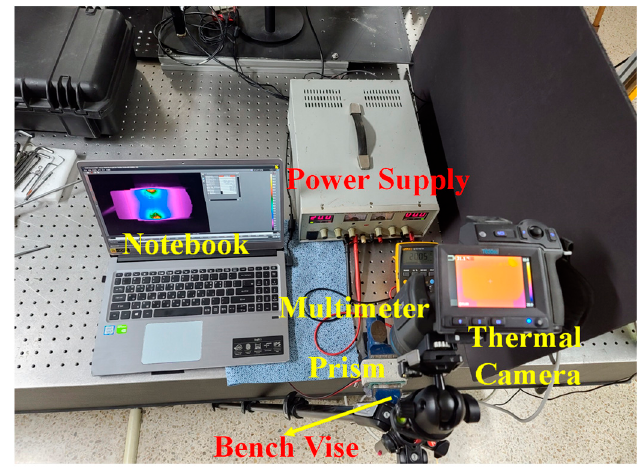
Figure 2. Experimental set-up.